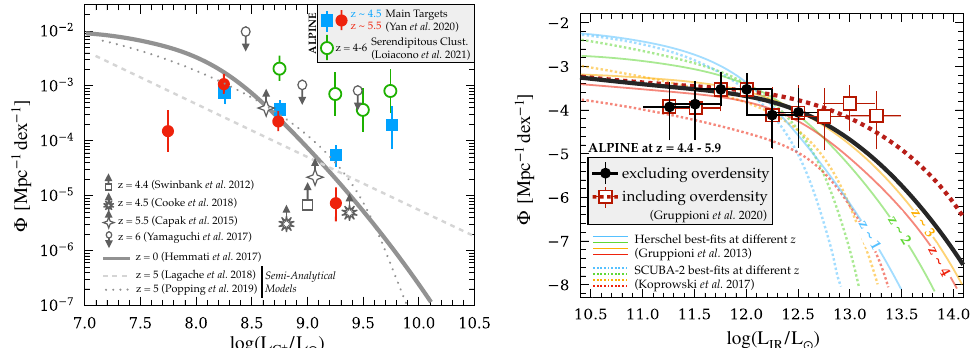
Figure 3. C + line emission and total far-IR LFs from ALPINE and literature. Left Panel: C + LF measured for the ALPINE main sample (blue squares, z ∼ 4.5; red circles, z ∼ 5.5; Yan et al. [64]) as well as serendipitous sample (incl. clustered galaxies) from the ALPINE blind survey (green open circles; [43]). Note that the counts of serendipitous C + emitters may be elevated due to clustering (see details in [43]). Other results from the literature [31,74–76] at z = 4.4, 4.5, 5.5, and 6 are also shown with respective symbols (mostly limits). For comparison, the z ∼ 0 C + LF from Hemmati et al. [65] is shown (solid gray line) as well as predictions from semianalytical models (gray dashed and dotted lines; [77,78]). Note that the ALPINE data become significantly incomplete and uncertain at L C + < 10 8.5 L (cid:12) due to survey limits and the uncertain incompleteness correction because of the lack of blindly detected C + samples (serving as incompleteness correction sample for the main targets). Hence, LF is the lower limit. Figure adapted from Yan et al. [64] and Loiacono et al. [43]. Right Panel: Total far-IR LF from ALPINE continuum detections at z = 4.5–5.9 [66] excluding overdensities (black circles) and including overdensities (open red squares). The solid, thick black line and dotted red lines, respectively, show the best-fit Schechter functions. The best fits to measurements from Herschel (thin solid lines; [79]) and SCUBA-2 S2CLS (thin dotted lines; [80]) for different redshifts (from z = 1 to z = 4; from blue to red) are also shown. Adapted from Ref.